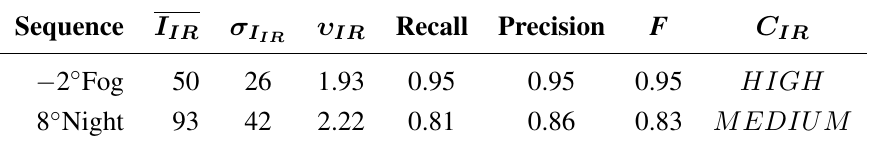
Table 3. Confidence values C to LOW